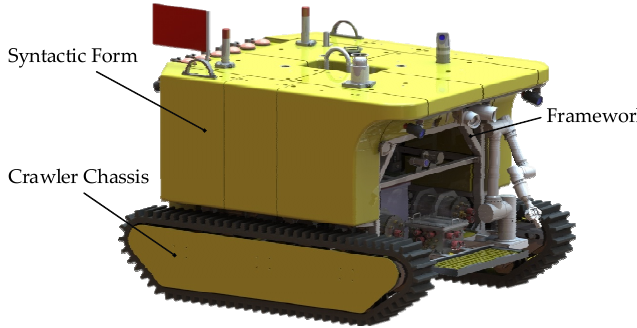
Figure 2. Conceptual prototype and configure of the DSLV.